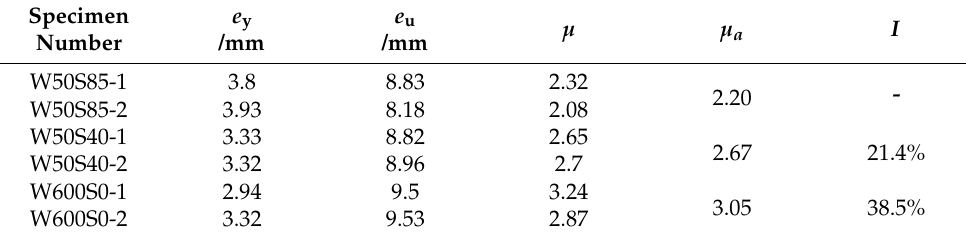
Table 5. Ductility of the